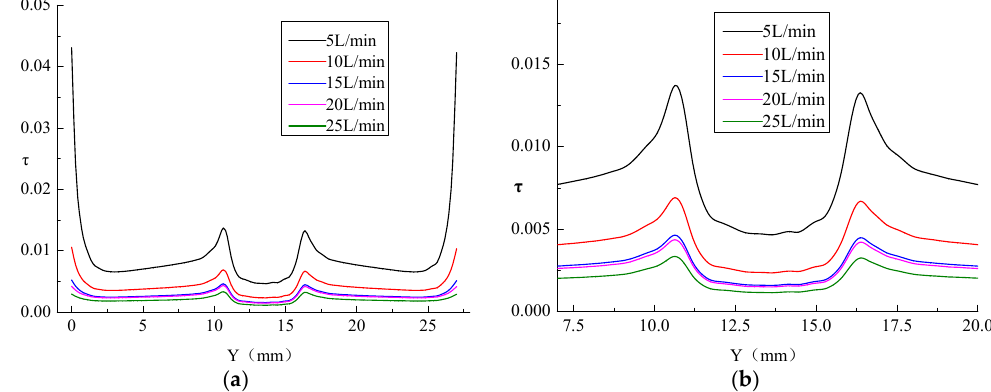
Figure 5. Coefficient distribution of pressure pulsation at the leading edge monitoring lines under different flow conditions at 80° opening degree. ( a ) The complete view. ( b ) The local enlarged view.